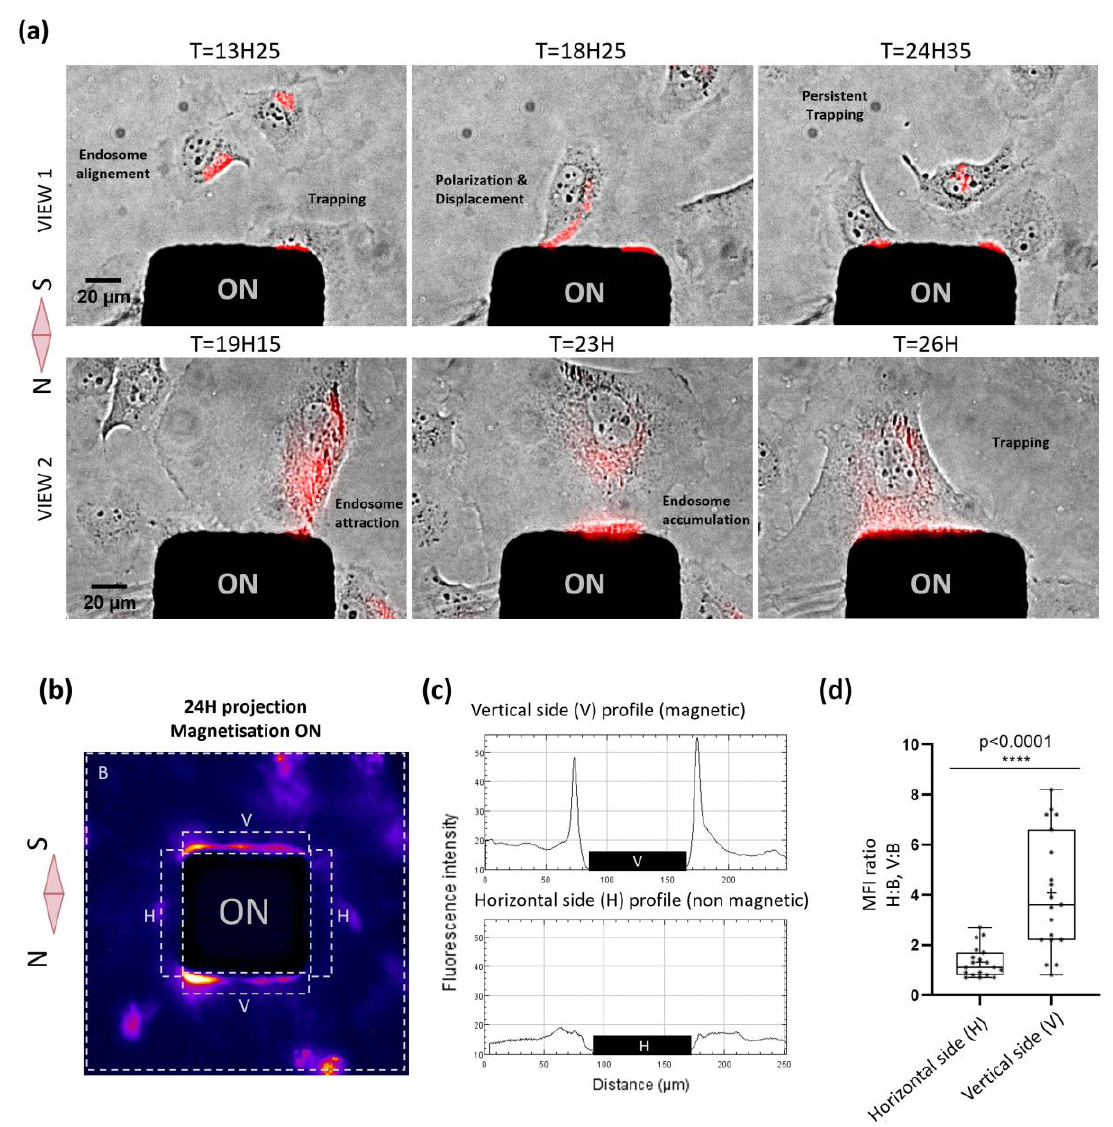
Figure 2. Parallelized magnetic manipulation of HeLa cells. ( a ) Images of 2 representative views at different times of magnetic attraction, showing cellular responses, such as polarization, displacement or trapping toward the magnetic pole, consequently to the attraction and accumulation of the magnetic endosomes, depicted in red. ( b ) Averaged images ( n = 19) of mean fluorescence intensity time projection comprising the different areas measured to estimate the magnetic cellular trapping: V (vertical magnetic pole), H (horizontal non-magnetic pole) and B (background total area). ( c ) Plots representing the Fluorescent intensity profile at the magnetic pole (vertical side) and at the non-magnetic pole (horizontal side) of the micro-pillar. ( d ) Histogram comparing the cell enrichment in the region close to the magnetic pole (V) and close to the non-magnetic pole (H, control). MFI = mean fluorescence intensity.